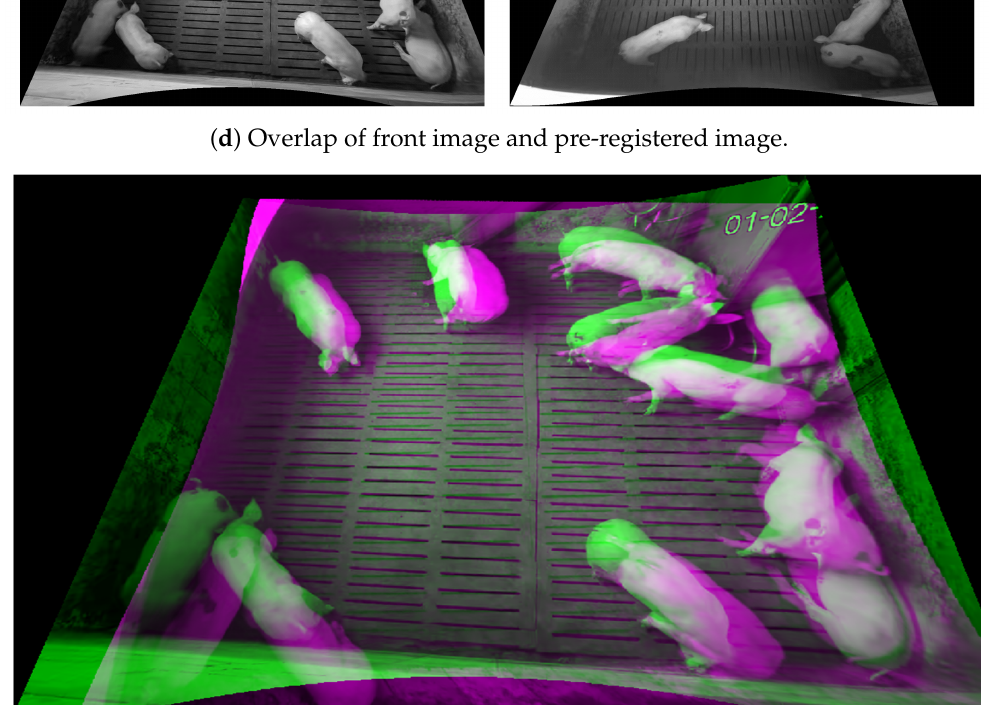
Figure 2. Image pairs at various stages of